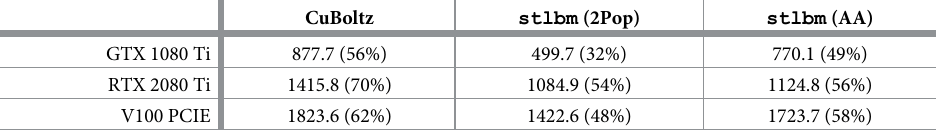
Table 3. Performance values of stlbm and the reference Cuda code CuBoltz for the lid-driven cavity at N = 128, with the BGK-W2 collision model. Performance is indicated in MLups, followed in parenthesis by the ratio between this performance and the theoretical peak performance, computed for a memory bandwidth of 480 GB/s (GTX 1080 Ti), 616 GB/s (RTX 2080 Ti), and 900 GB/s (V100